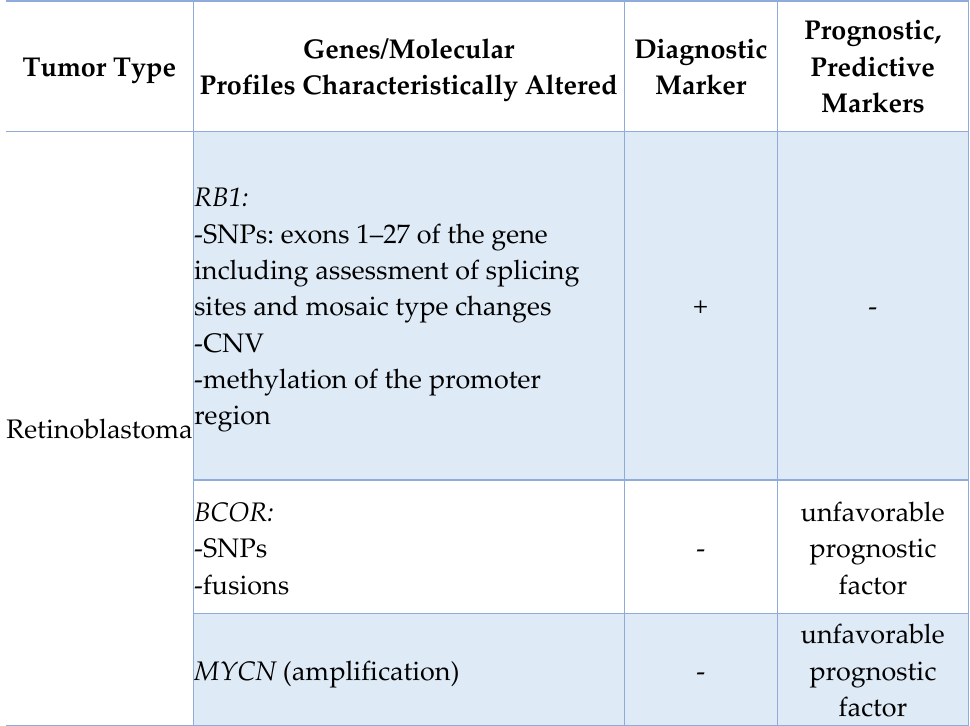
Table 7. Molecular markers—retinoblastoma.